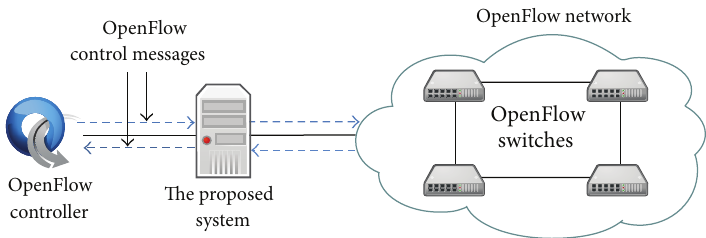
Figure 2: The architecture of OpenFlow network with our proposed monitoring system.